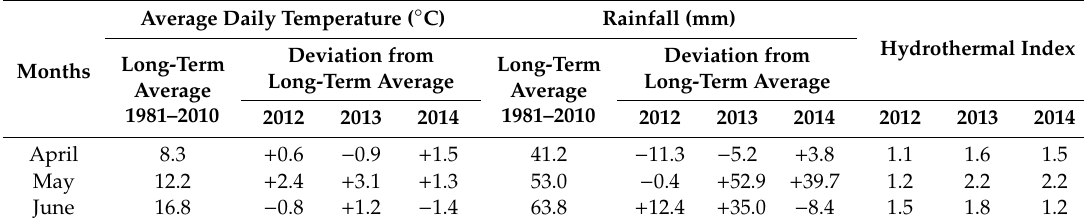
Table 1. Hydrothermal conditions during potato growing period.